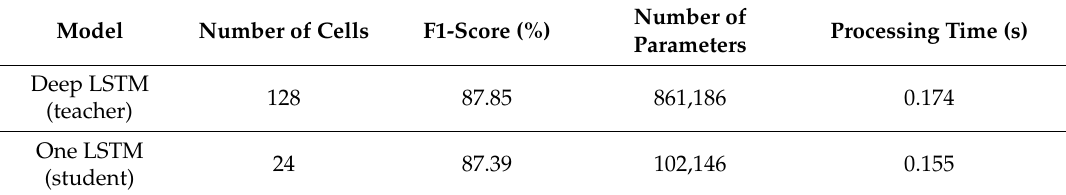
Table 5. Comparison of parameters and processing time according to teacher–student model configuration. In the experiment, the parameters and processing time for ResNet50 were